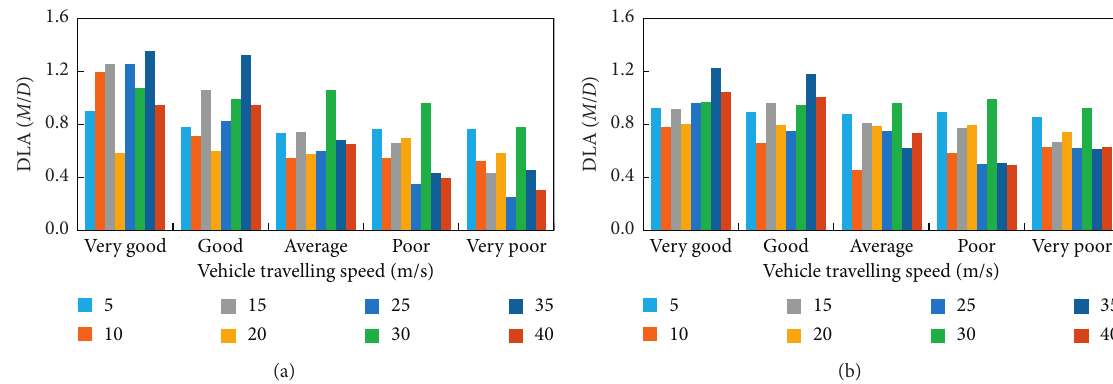
Figure 15: DLAs for the different responses of the arch rib: (a) DLA M/D and (b) DLA N/D. 0.04.08.012.016.020.0 A L D